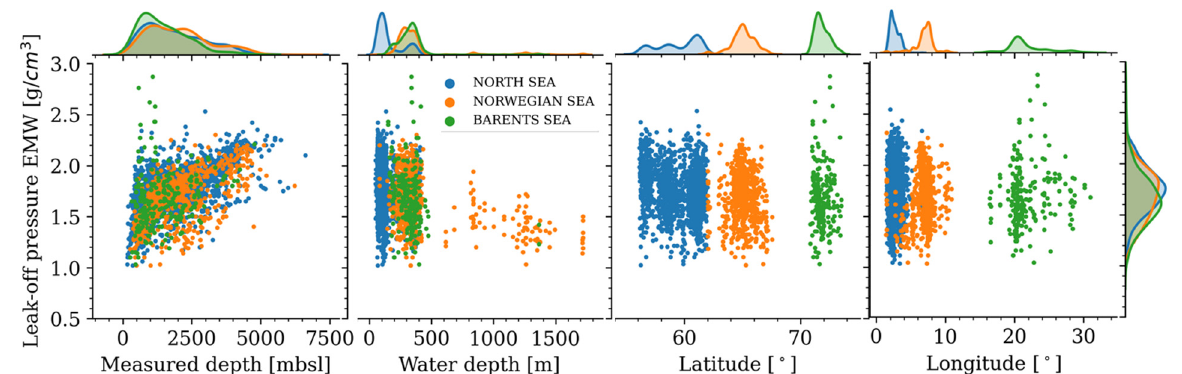
Table 2. Statistics of geospatial information for leak-off pressures in the analyses.